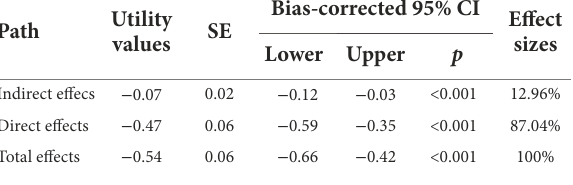
TABLE 4 Hope mediating effects.